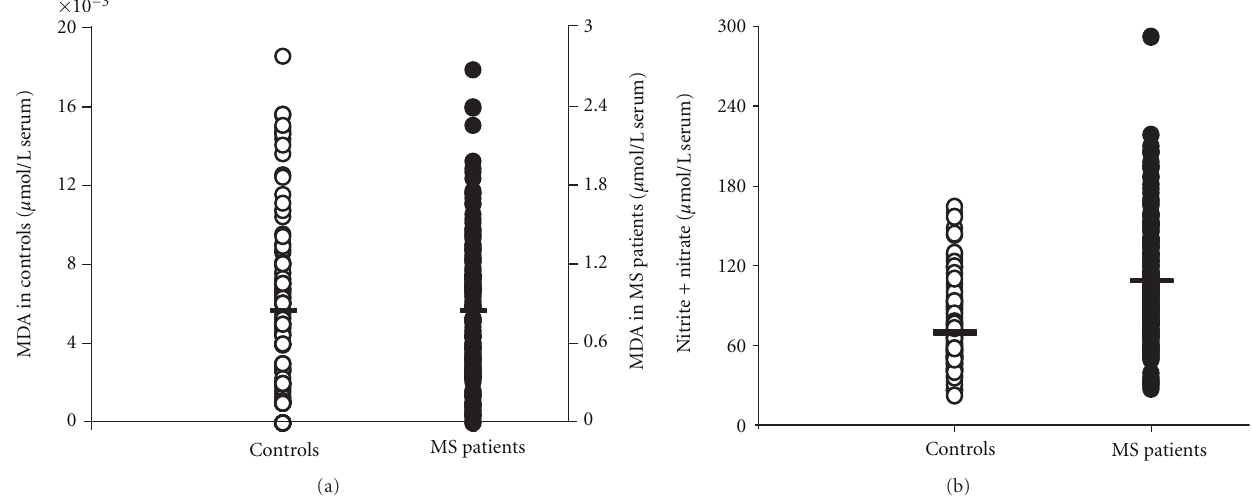
Figure 4: Scatter plot showing the concentrations of MDA (a) and sum of nitrite and nitrate (b) recorded in serum 163 controls healthy and 170MS patients. Horizontal bars indicate the mean values calculated in the two